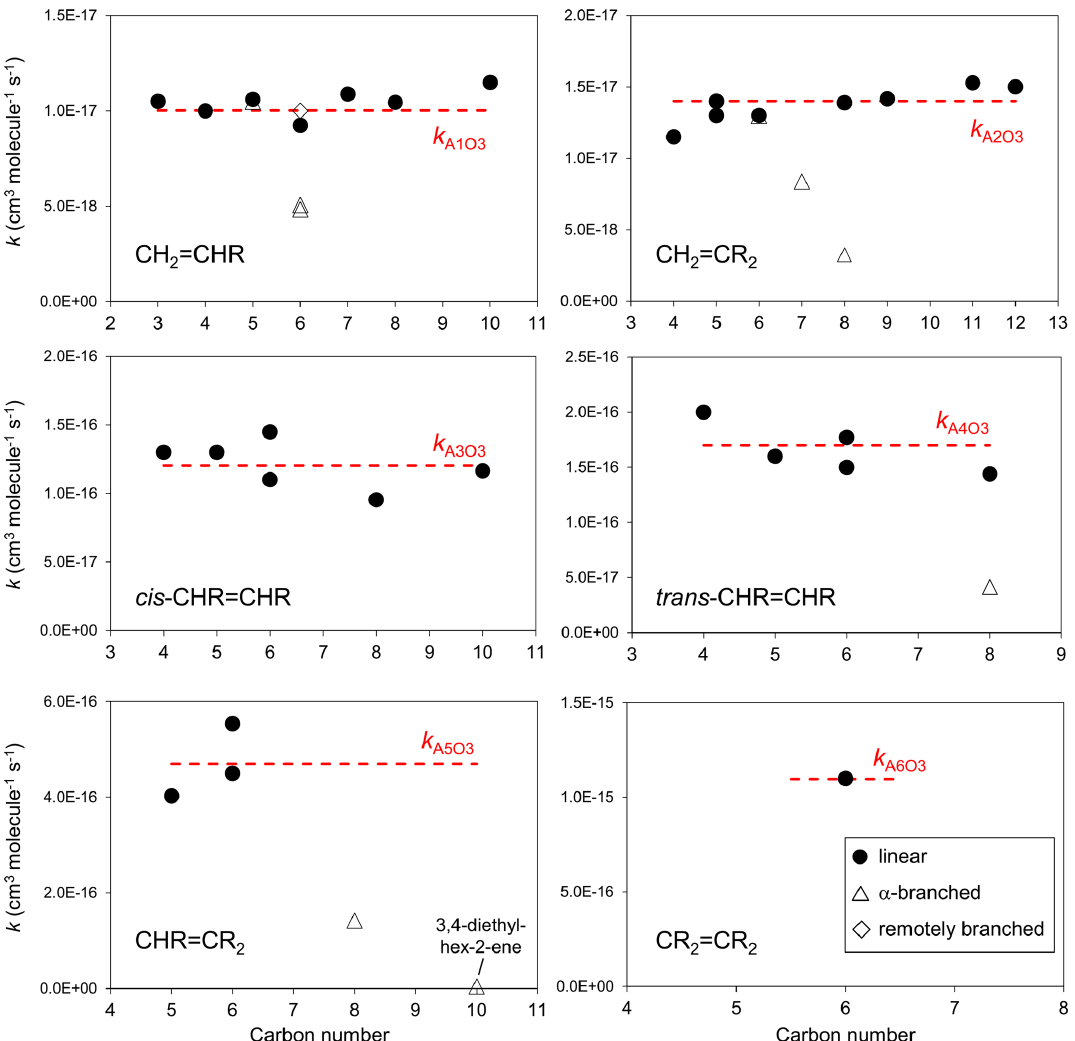
Figure 1. Preferred kinetic data for the reactions of O 3 with acyclic monoalkenes at 298K as a function of carbon number, and the assigned rate coefficients for the generic monoalkene structures with linear alkyl substituents, as given in Table 1 (NB the α -branched R data in the trans -CHR=CHR panel consist of two co-incident data